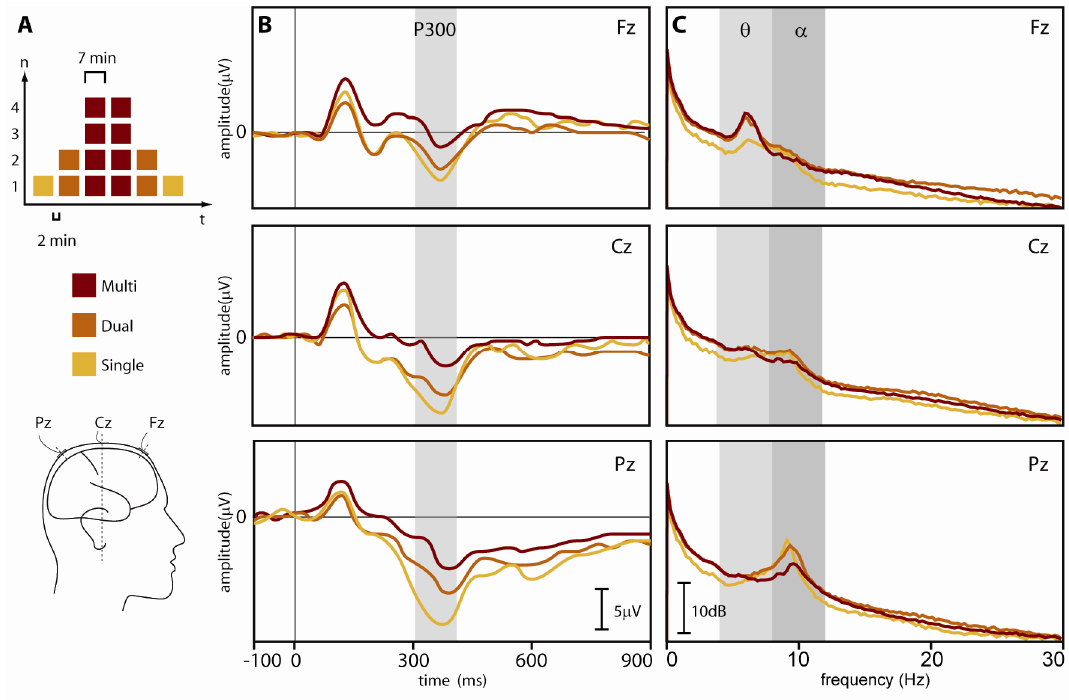
FIGURE 2. EEG spectrum is modulated by external demands. (A) Task setup. In the single condition, subjects performed an auditory attention task; in the dual condition, the auditory task together with an arithmetic task; and in the multi condition, four tasks (auditory, arithmetic, memory, and visual) concurrently. (B) Auditory ERPs in different task conditions. Increasing task demands decreased the P300 amplitude in the parietal area Pz (F[1.5, 23.4] = 28.2, p = 0.001, n = 20). Negative plotted upwards. (C) EEG spectra. Increasing task demands increase frontal theta (Fz) and decrease parietal alpha (Pz). Only the change in alpha range is statistically